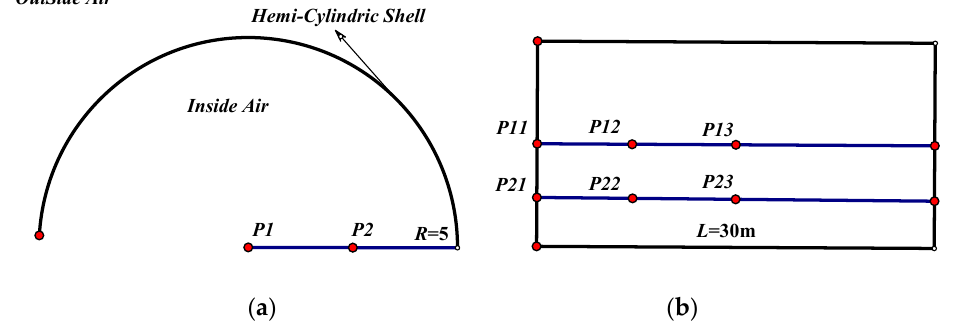
Figure 7. The sketch of the finite element model. ( a ) The mesh in the Z=0 plane, ( b ) The mesh of 3-D